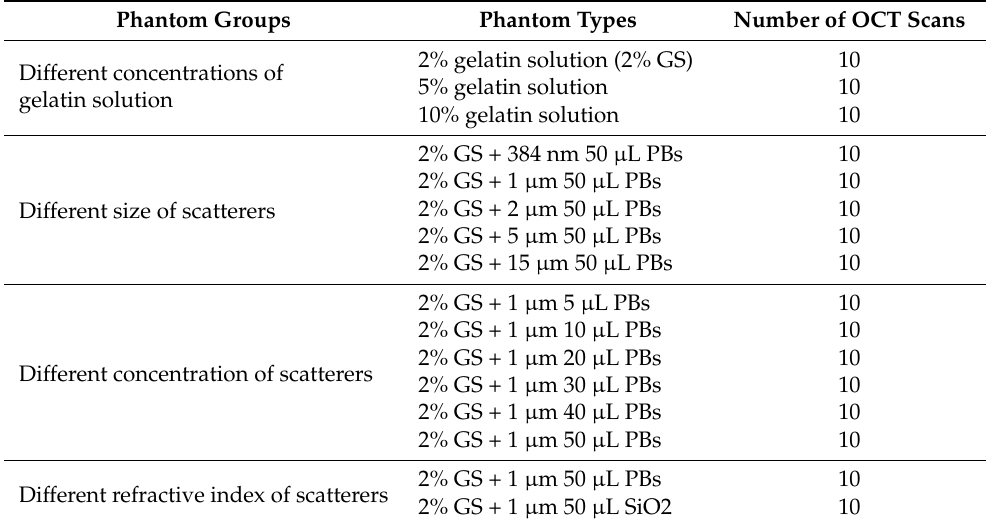
Table 1. Groups and types of phantoms. Phantom Groups Phantom